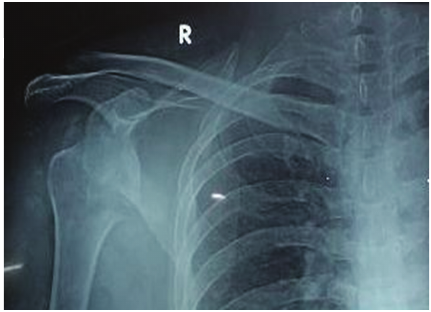
Figure 3: Radiographs of right anterior shoulder dislocation (pre-